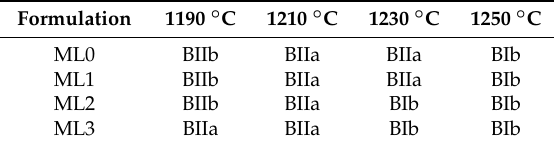
Table 6. Classification of the ceramic floor tiles containing MWS waste according to the ISO standard